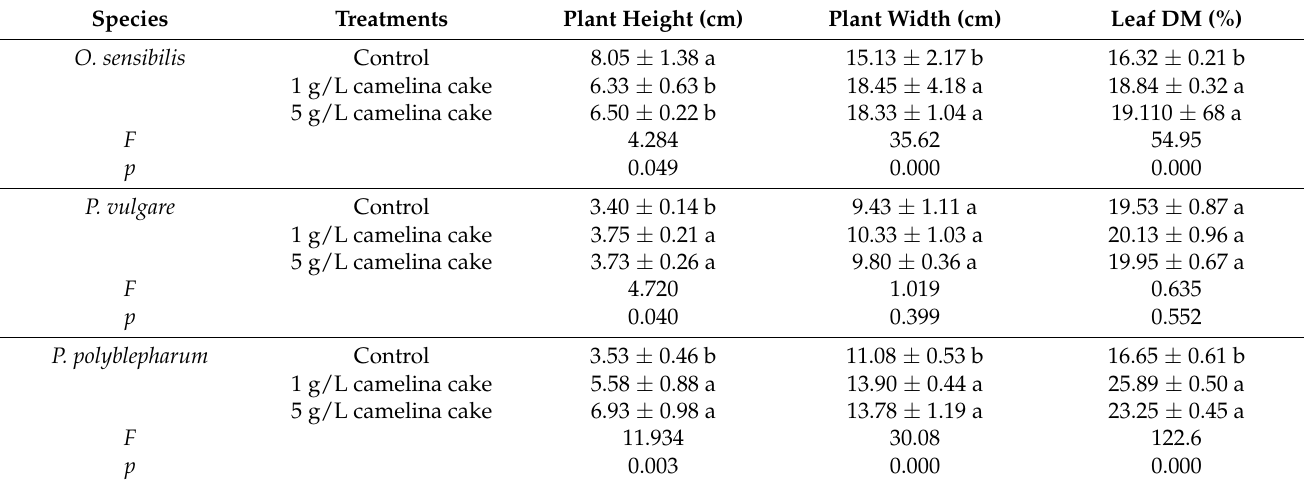
Table 2. The effect of amending peat substrate with camelina cake pellet on plant height, plant width, and leaf dry matter (DM) of three species of ferns from rooted cuttings after 90 days of greenhouse